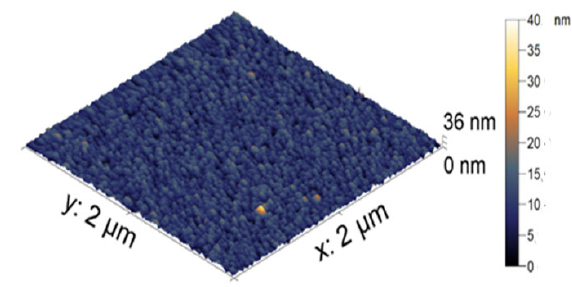
Figure 3. AFM images of the PNIPAM ‐ PAA microgel.